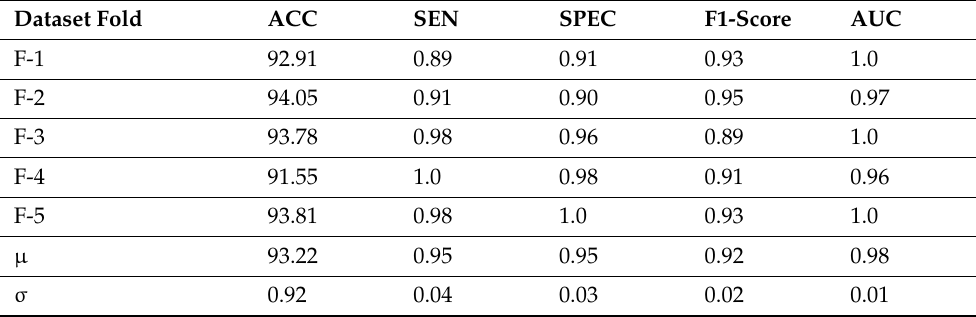
Table 5. Average ACC in %, SEN, SPEC, F1-Score, and AUC using five-fold cv with XGB-SMOTE. Dataset